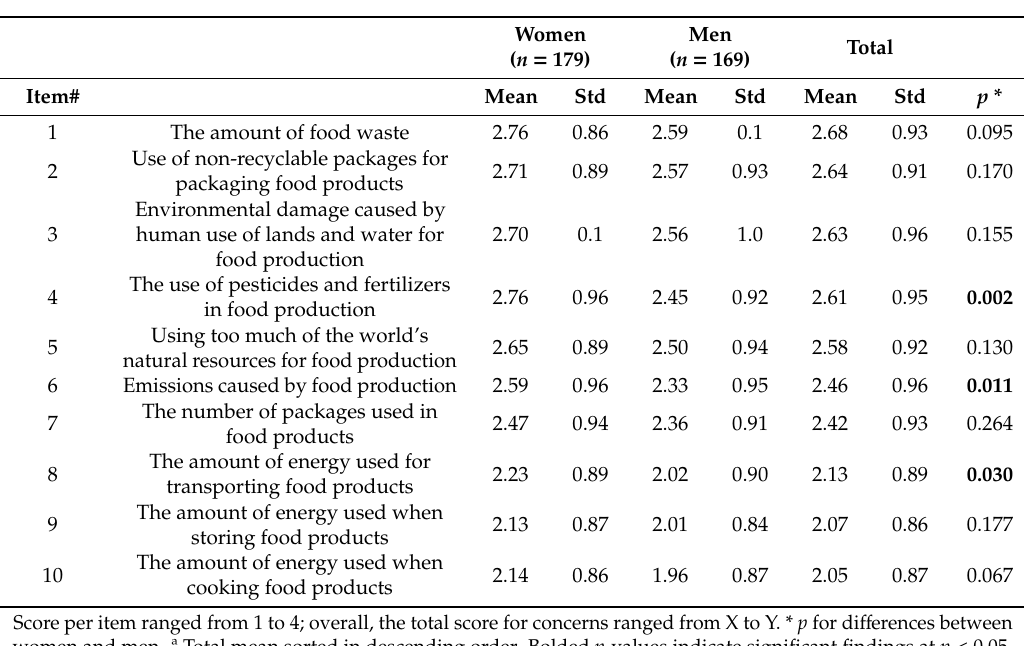
Table 2. Food-related sustainability concerns ª by gender.